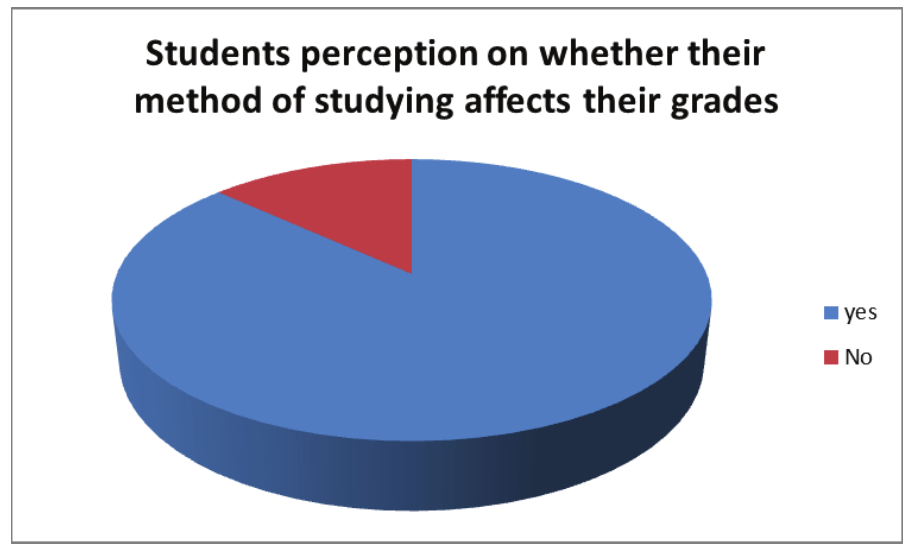
Figure 2 : Students’ perception on whether their method of study affects their